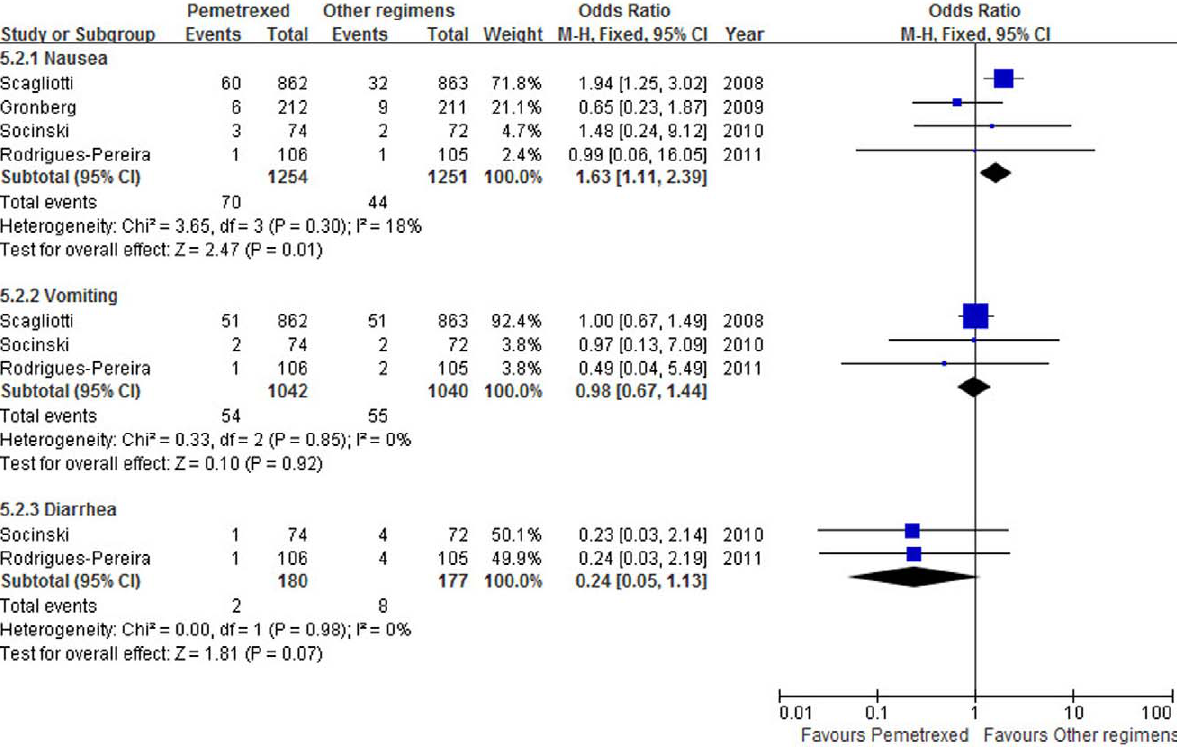
Figure 7. Summary of grade 3–4 nonhematological toxicity. Abbreviations: M-H, mantel-haenszel; CI, confidence interval.